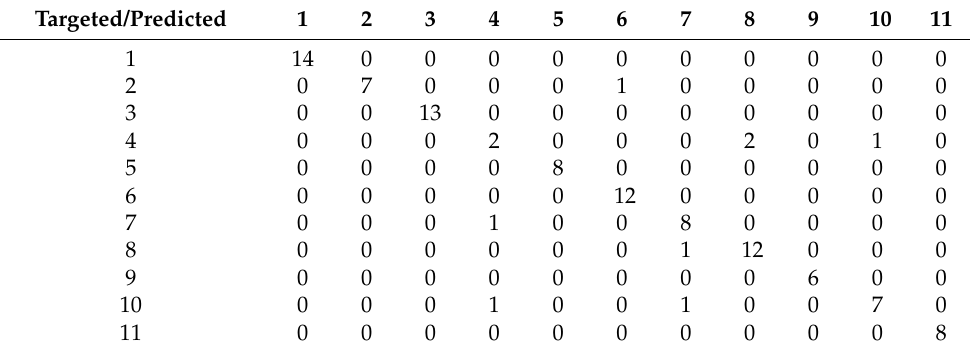
Table 3. The confusion matrix for ConvLSTM [18].